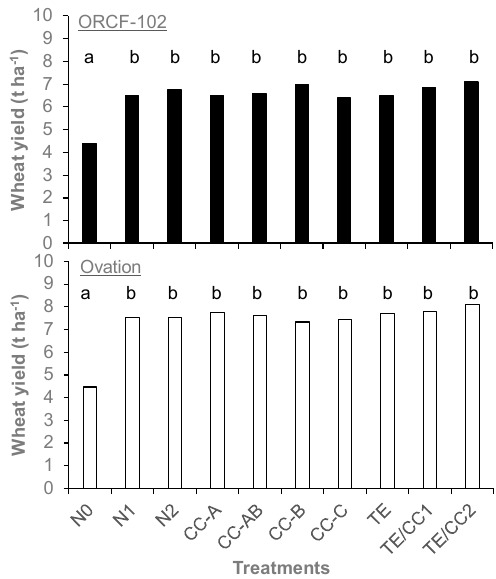
Figure 2. SWWW yield (t ha − 1 ) among PGR—fertilization treatments across two years in Adkins fine sandy loam soil in Oregon. N0 = no fertilization; N1 = normal N rate; N2 = high-N rate without PGR application; CC-A = applying CC at GS30-32; CC-AB = applying CC at GS30-32 and GS37-39; CC-B = applying CC at GS37-39; CC-C = applying CC at GS21-26; TE = applying TE at GS30-32; TE/CC1 = applying TE at GS30-32 and applying CC (0.442 L ha − 1 a.i.) at GS37-39; TE/CC2 = applying TE at GS30-32 and applying CC (1.004 L ha − 1 a.i.) at GS37-39. Different letters on the top of each column indicate significant differences among treatments at 5% level according to LSD test.